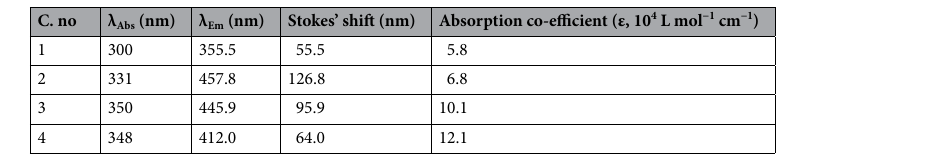
Table 1. Photophysical properties of compounds 1 –